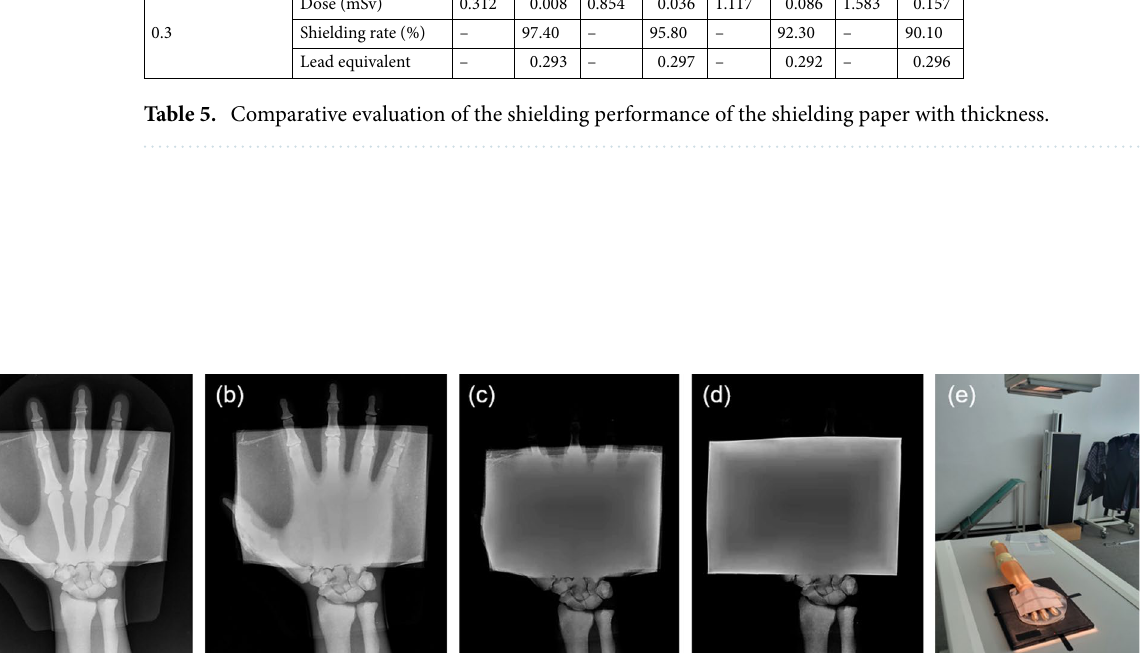
Figure 11. X-ray images of a phantom hand covered with ( a ) one shielding paper, ( b ) two shielding papers, ( c ) three shielding papers, and ( d ) 0.25 mm lead plate. ( e ) Phantom X-ray